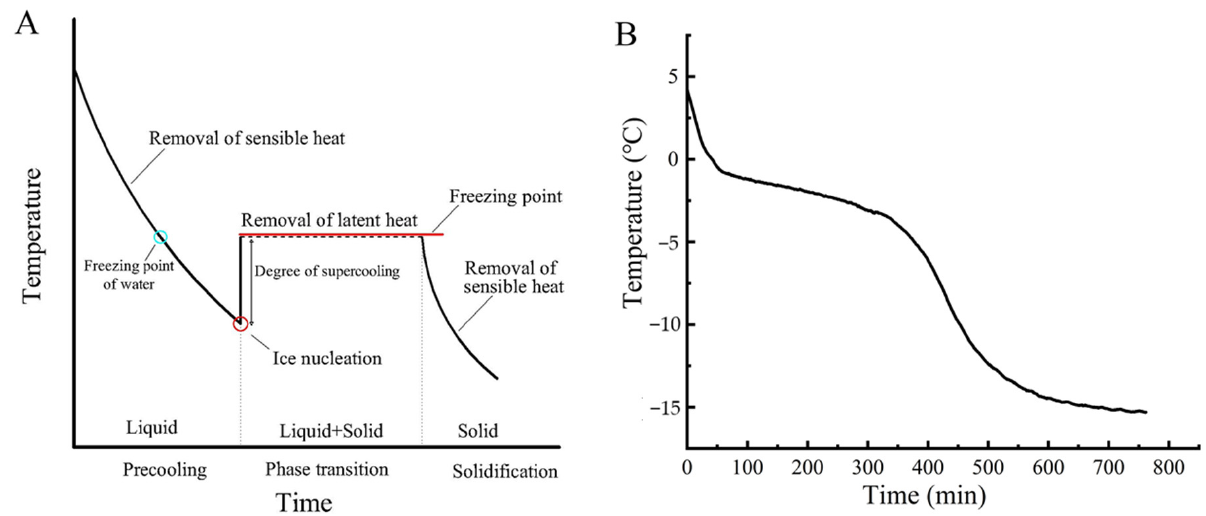
Figure 1. Typical time-temperature curve ( A ) of water during freezing processes; Freezing curves ( B ) for the centers of large yellow croakers with − 20 ◦ C refrigerator, and the Figure 1B was created from own data by the